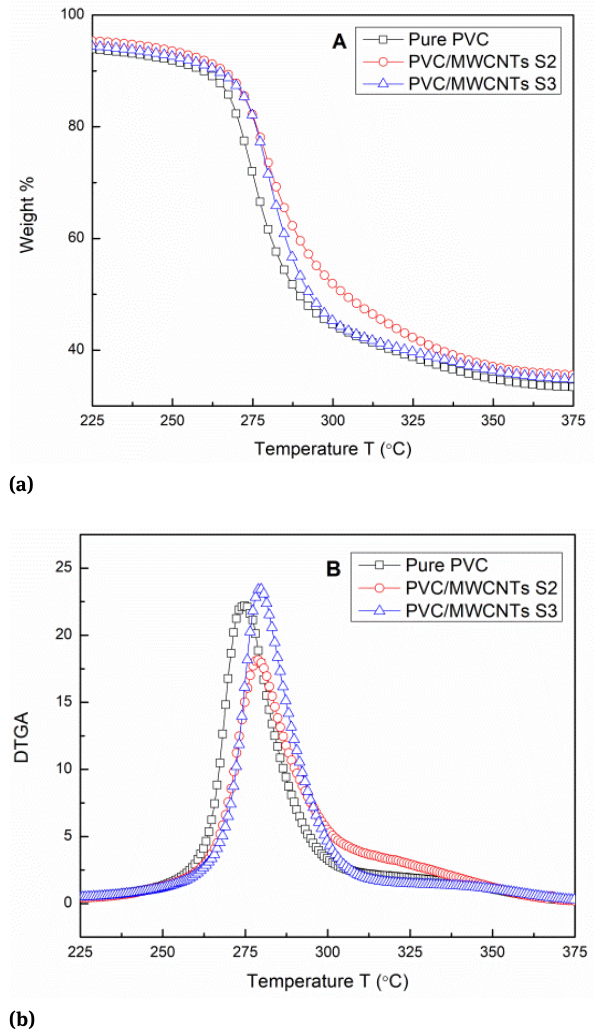
Figure 8: a) TGA and b) DTGA curve for PVC and PVC/MWCNTs nanocomposite (S2 and S3)